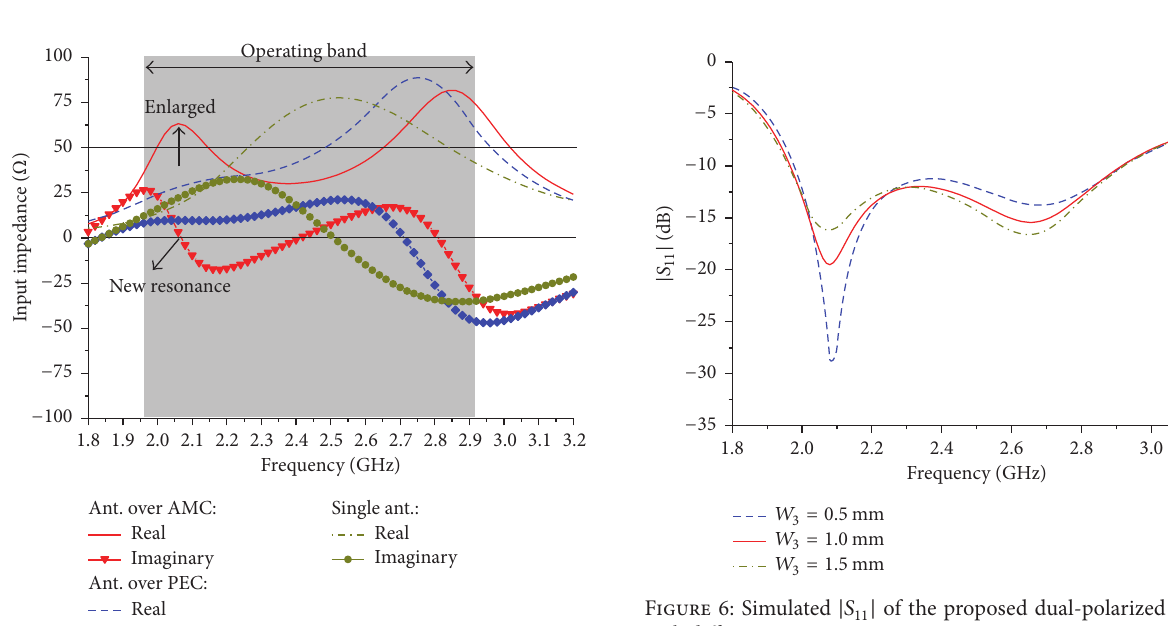
Figure 3: Simulated |𝑆 11 | of the different dual-polarized slot anten- nas.